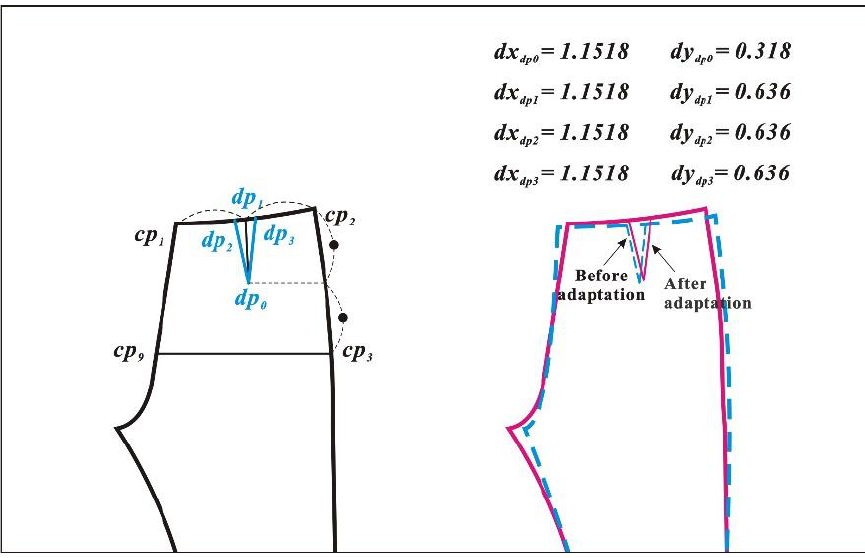
Figure 9. Associated adaptation of the waist dart.